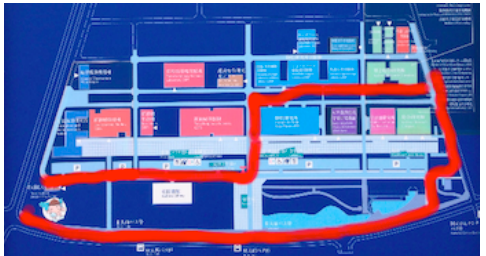
Figure 8. Positioning results of user’s trajectory on related prototype of outdoor navigation system